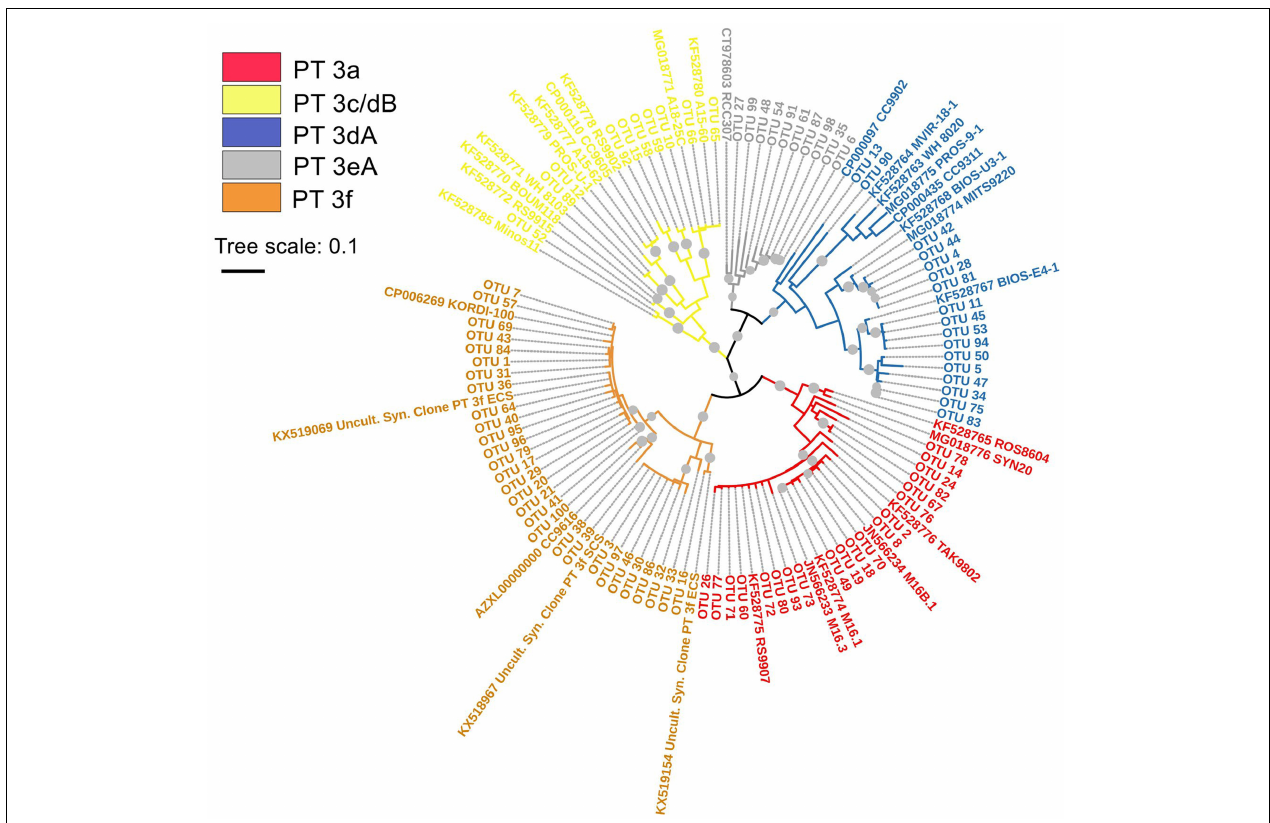
FIGURE 2 | Maximum likelihood phylogenetic tree of cpeBA operon sequences of abundant operational taxonomic units (OTUs) detected in eastern Indian Ocean (EIO), surface water of coastal waters of Sri Lanka (SSL), and the Strait of Malacca (SSM) with bootstrap of 1,000 replicates. The bootstrap values higher than 50% are displayed as gray circles. The abbreviation of Uncult.Syn. Clone PT 3f ECS and SCS represents the uncultured Synechococcus clone sequence of PT 3f detected in East China Sea (ECS) and South China Sea (SCS),